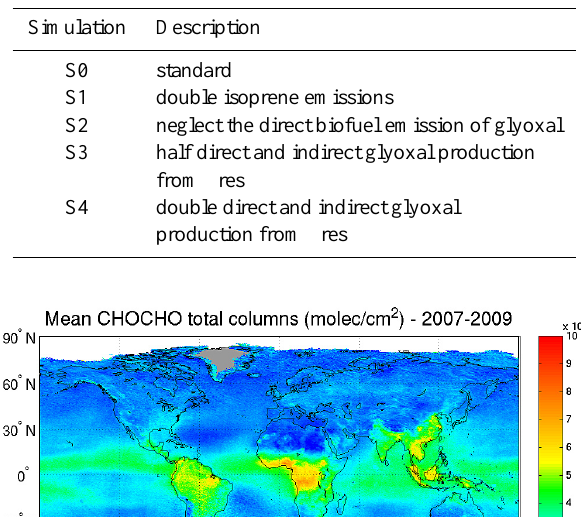
Table 3. Performed global model simulations.